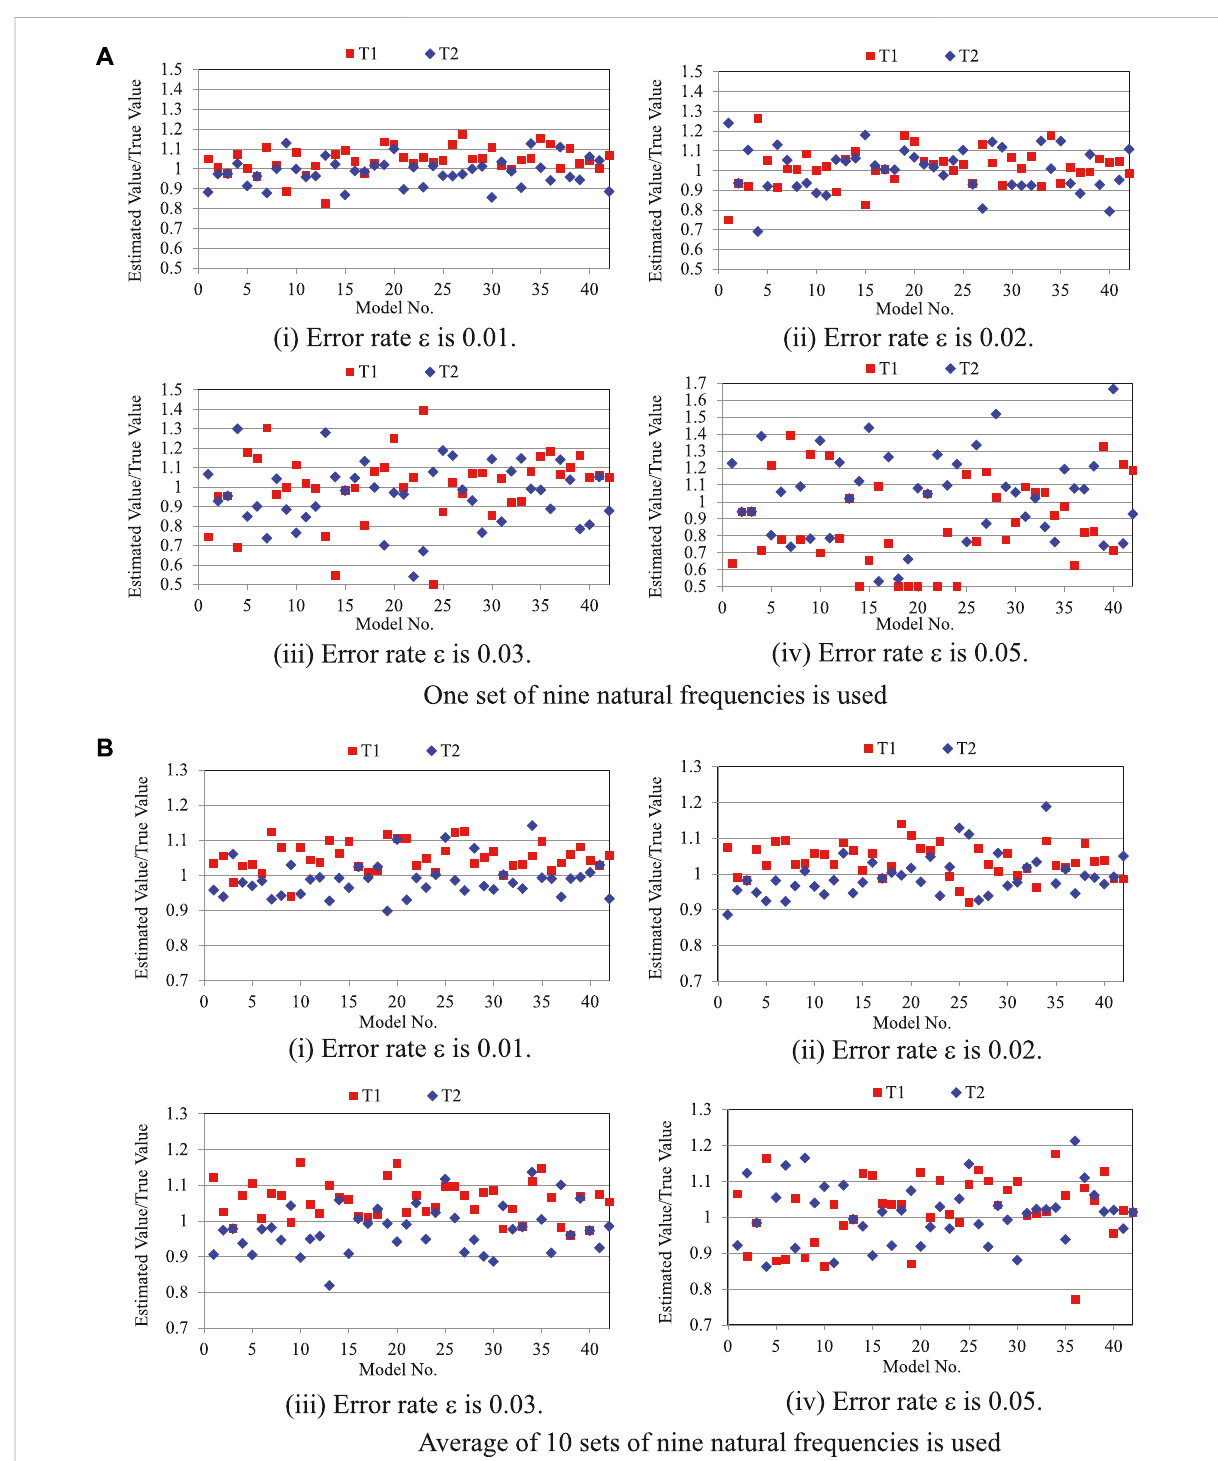
FIGURE 6 Estimation results with measurement error. (A) One set of nine natural frequencies is used. (B) Average of 10 sets of nine natural frequencies is